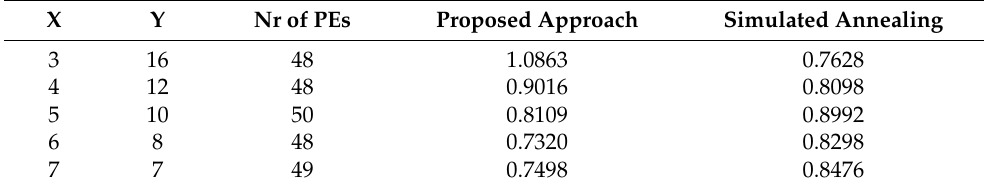
Table 3. Influence of array geometry on the quality of the floorplanning results. Comparison of normalized values of minimization objective function (lower is better).